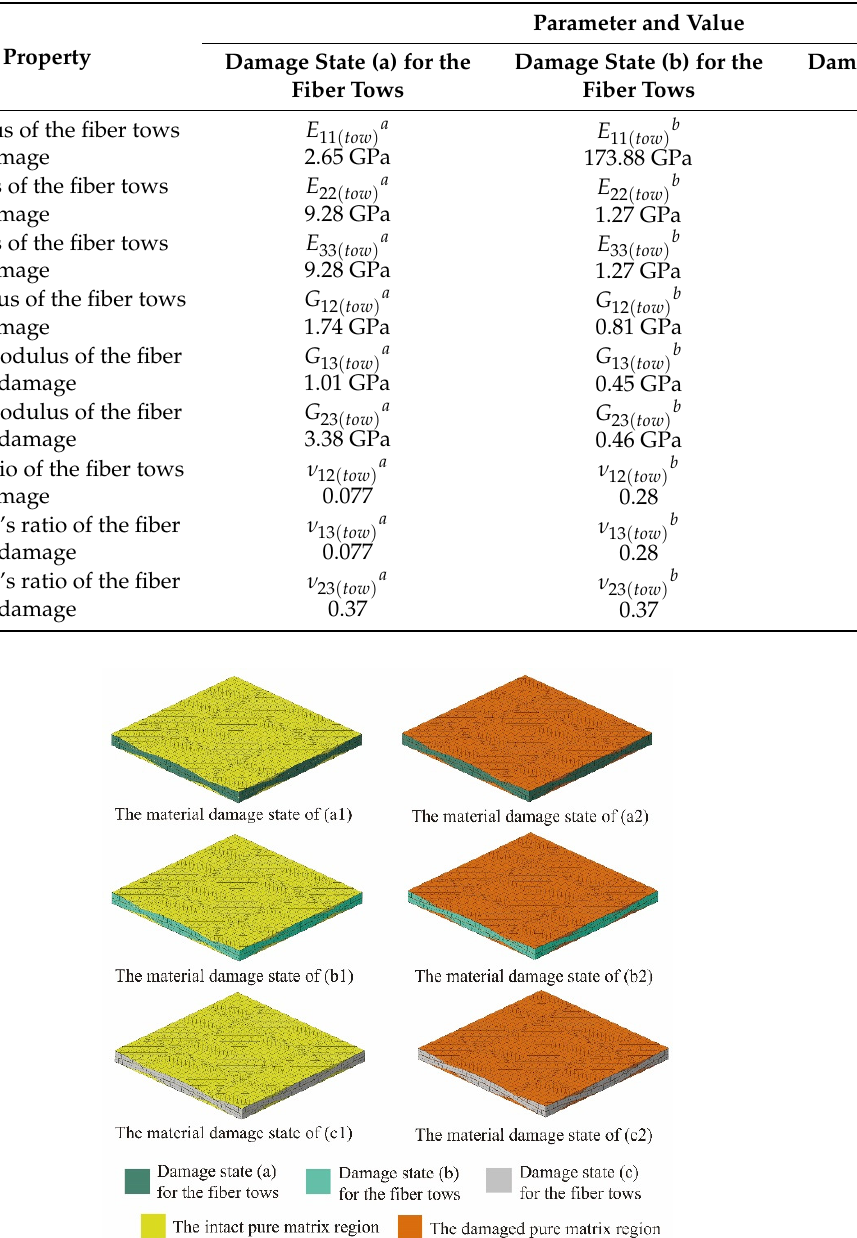
Table 14. Macro-scale mechanical properties of the T300/Epoxy PWF composite after the damage initiation.